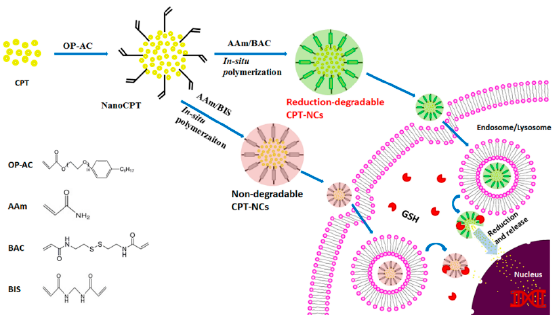
Figure 1. Schematic illustration showing the preparation and cellular uptake of the camptothecin nanocapsules (CPT-NCs). GSH: glutathione; BAC: N , N ′ -bis(acryloyl) cystamine; OP-AC: acrylated-